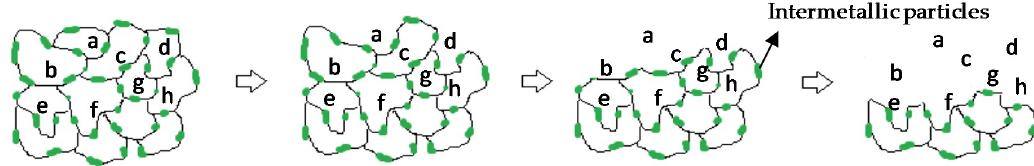
Figure 12. Schematic diagram of corrosion attack at the grain boundary and loss of grains (labeled with letters).